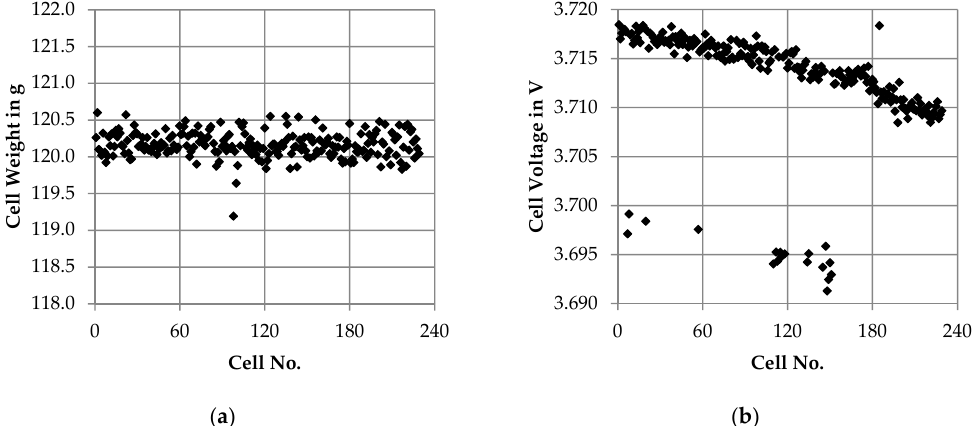
Figure 5. Main results of the receiving inspection: ( a ) distribution of the cell weight and ( b ) distribution of the open circuit voltage measured before running initial tests.